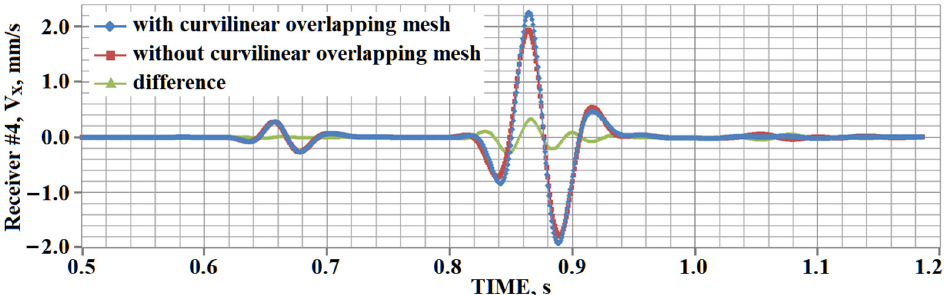
Figure 13. Receiver #4, dependencies of X-component of velocity on time.